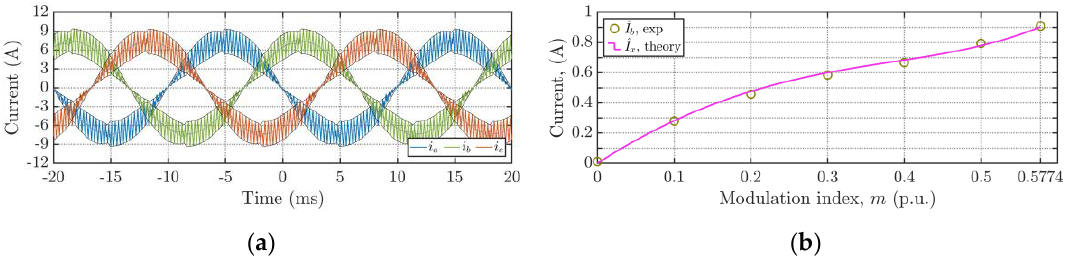
Figure 41. ( a ) Phase currents with primary (black) and secondary (gray) envelopes in case of DPWM2 ( m = 1/√3); ( b ) Phase current ripple rms in case of DPWM2.